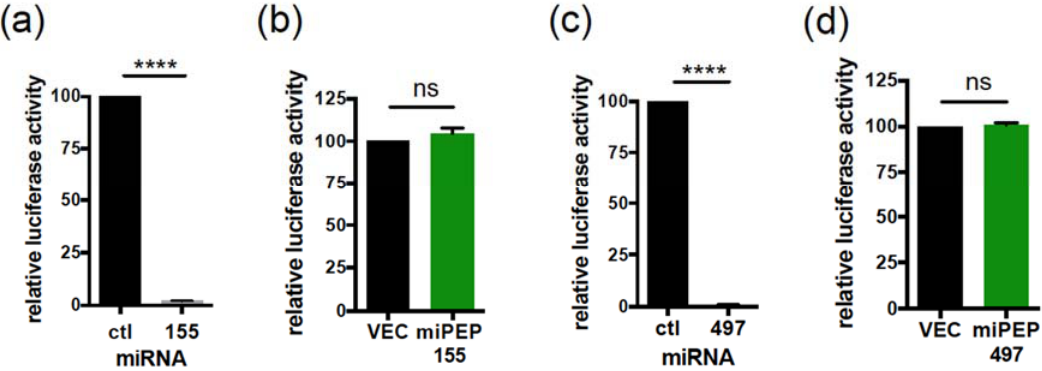
Figure 3. The miPEP155 and miPEP497 do not regulate the activity of their corresponding miRNA. ( a , c ) miR-155 ( a ) and miR-497 ( c ) activities upon overexpression of miR-155 ( a ) or miR-497 ( c ) into Hela cells. ( b , d ) Endogenous miR-155 ( b ) and miR-497 ( d ) activities upon overexpression of miPEP155 ( b ) or miPEP497 ( d ) into Hela cells. Cells were tested 48 h post-transfection for dual luciferase assays. ( a , c ) The relative luciferase activities of miRNA transfected cells were compared to that of the miR ctl transfected cells, set to 100. Data are means ± S.E.M. of three independent experiments. ( b , d ) The relative luciferase activities of the miPEP transfected cells were compared to that of vector transfected cells, set to 100. Data are means ± S.E.M. of four independent experiments. ****: p < 0.0001. ns: not